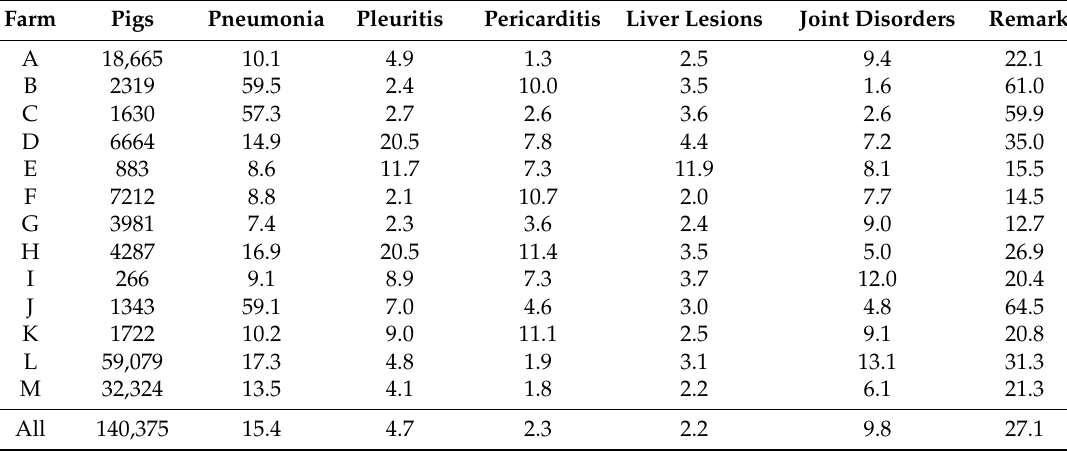
Table 1. Least-squares means of incidence (%) of slaughter remarks in different farms.